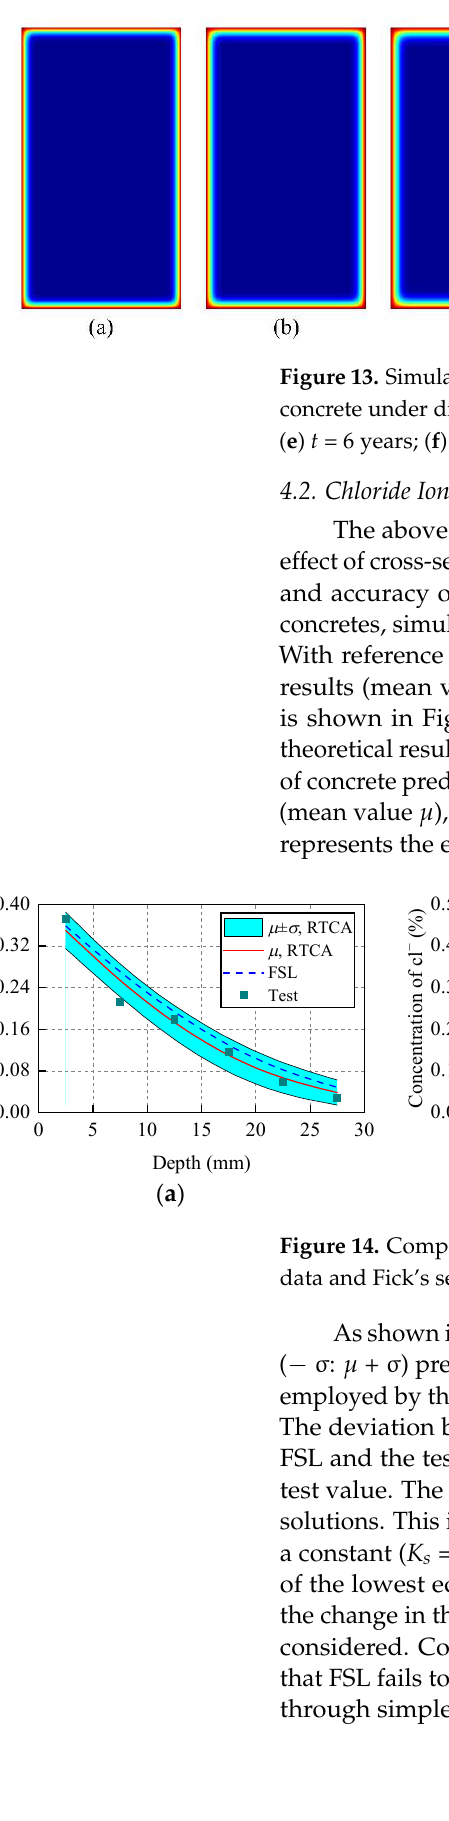
Figure 12. Simulation results (average value μ ) of the concentration of chloride ions in cross-section of PC concrete under different corrosion times: ( a ) t = 0.5 year; ( b ) t = 1 year; ( c ) t = 2 years; ( d ) t = 3 years; ( e ) t = 6 years; ( f ) t = 8 years.